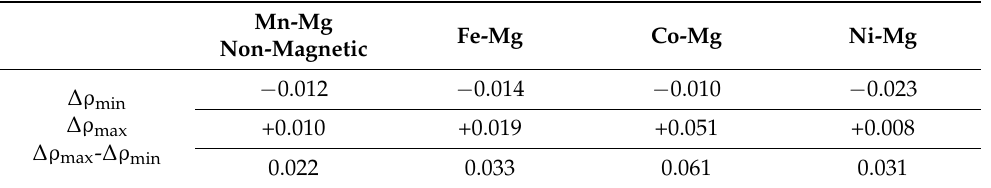
Figure 5. The charge redistribution (meV/ Å 3 ) in the ( 2  114) plane upon formation of Mg (A = Fe, Co, and Ni, and non-magnetic Mn) bond at the ( 2  114) twin boundary in Mg. Mn is spin restricted. Table 2. The variation of charge density redistribution ( e /Å 3 ) upon formation of X–Mg (X = Fe, Co, Ni, and non-magnetic Mn) bonds in the ( 2  114) plane at the ( 2  114) twin boundary in Mg (see Figure 5).